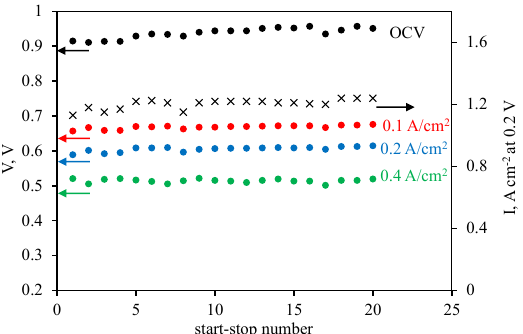
Figure 4. Variation of the open cell voltage and cell voltages measured at 0.1, 0.2, and 0.4 A cm − 2 variations with a start–stop cycle number. The MEA was assembled with the reinforced membrane, Celtec®P1000 anode, and CNF cathode. The second Y-axis shows the current density measured at 0.2 V in this series of experiments.